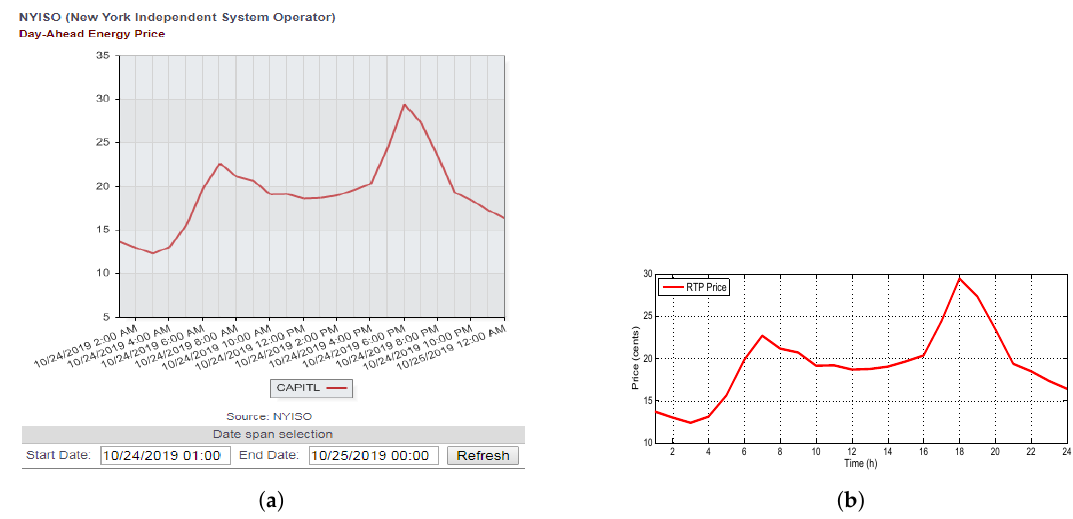
Figure 3. ( a ) Day-ahead pricing (DAP) signal [37], ( b ) Day-ahead pricing (DAP) signal